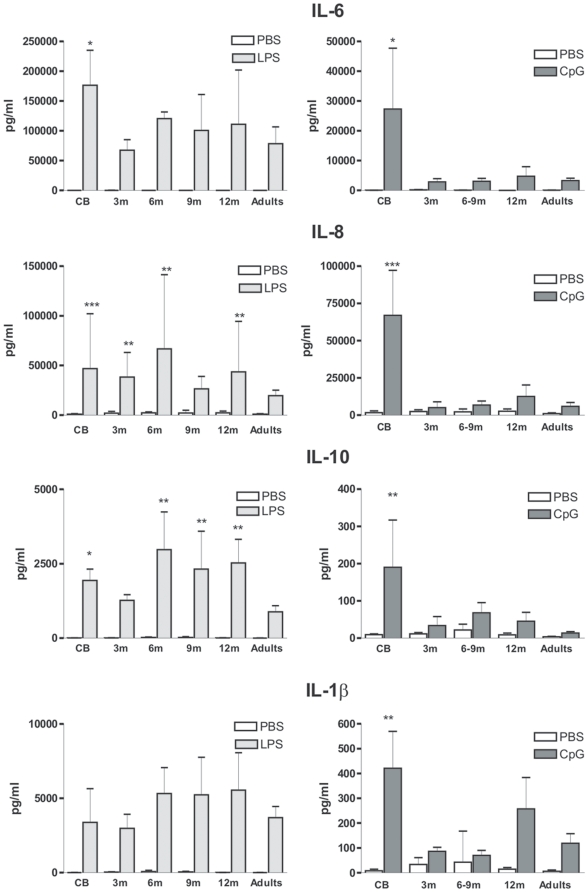
Hyperproduction of specific cytokines in early life.Whole blood samples were stimulated with the indicated TLR ligand and culture supernatants were collected after 16–18 h. Production in the different infant groups was compared to adult values. Cord blood (CB, n = 13), 3-month (3 m, n = 10), 6&9-month (6 m, n = 3, 9 m, n = 5), 12-month (12 m, n = 11) old infants and healthy adults (n = 10). Data are represented as median+interquartile range. *p<0.05, **p<0.01, ***p<0.001 as compared to stimulated adult samples.